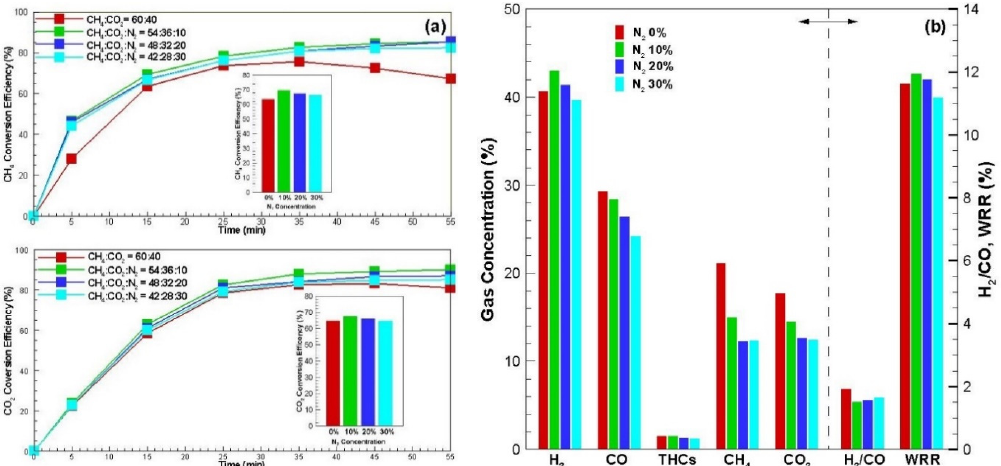
Figure 5. Reforming characteristics of biogas-nitrogen effect. ( a ) CH 4 and CO 2 conversion efficiencies and ( b ) average concentration of the product gas, H 2 /CO ratio and weight reduction rate.